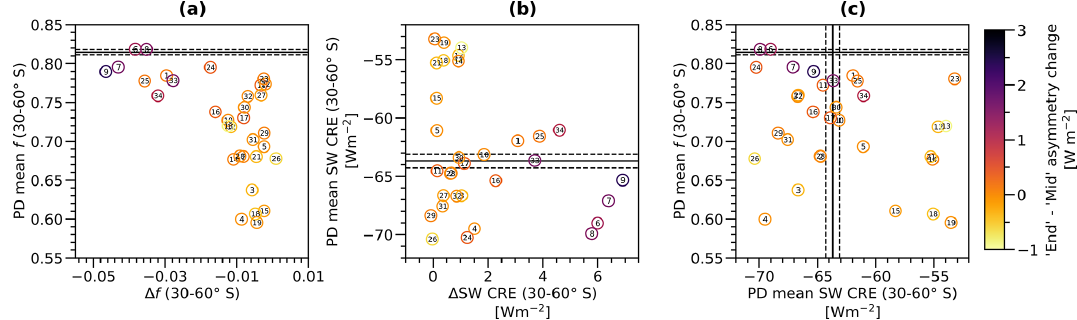
Figure 5. SH extratropical (30–60 ◦ S) mean (a) cloud fraction f and (b) SW CRE in PD conditions plotted against differences thereof between End and Mid. In (c) , PD mean SH extratropical f is plotted against PD mean SH extratropical SW CRE. Solid black lines represent CERES EBAF (SW CRE) and MODIS (cloud fraction) mean values over March 2000–February 2015, and dashed lines represent the bounds of 1 standard deviation in monthly mean anomalies. The color scale depicts modeled changes in asymmetry between End and Mid.